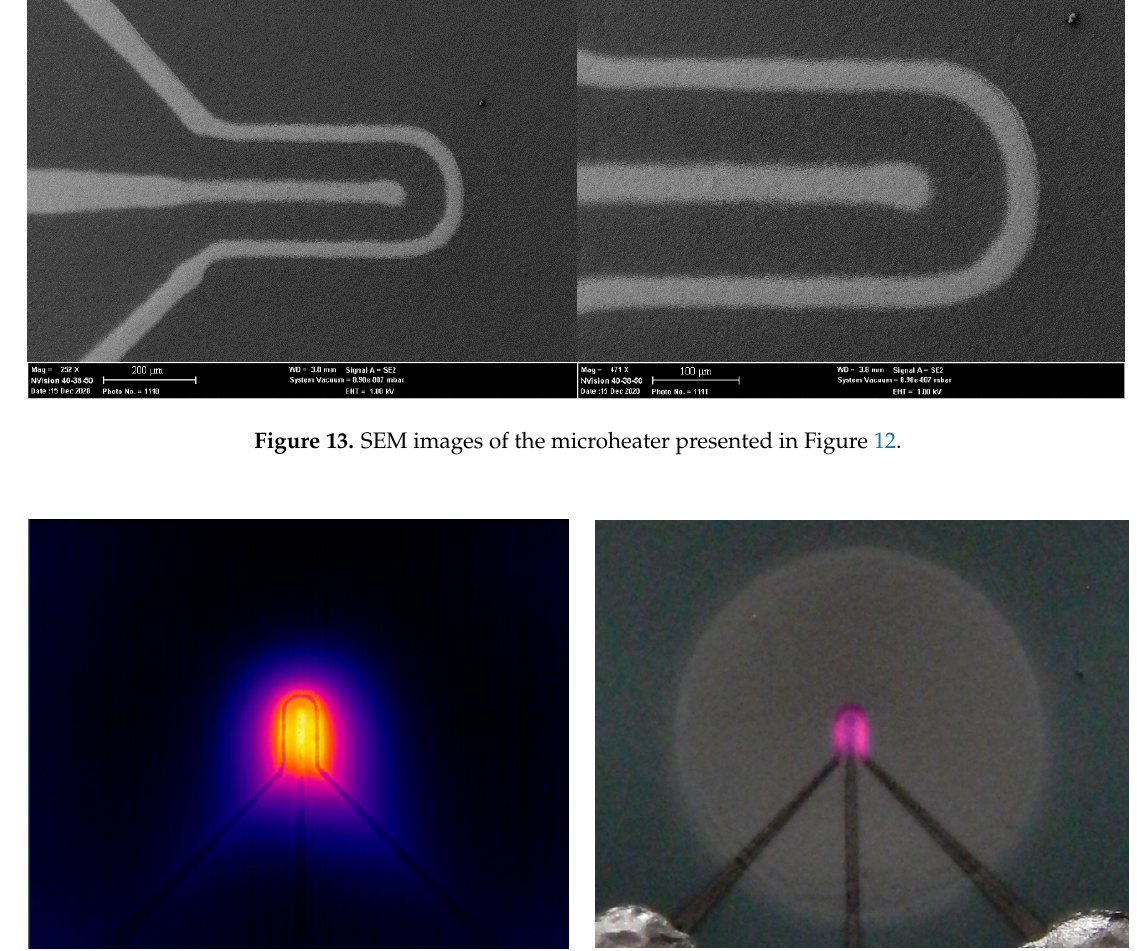
Figure 15. Power dependence of the temperature of the hot part of the microheater.